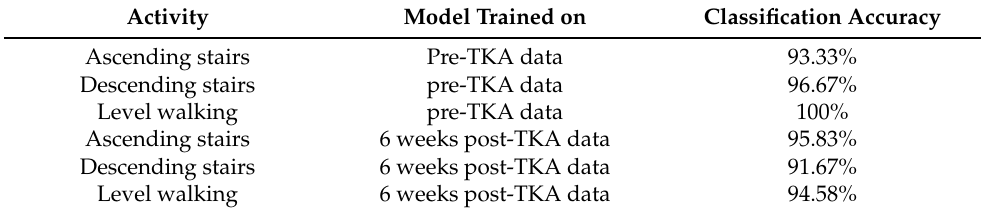
Table 3. Classification accuracies of all